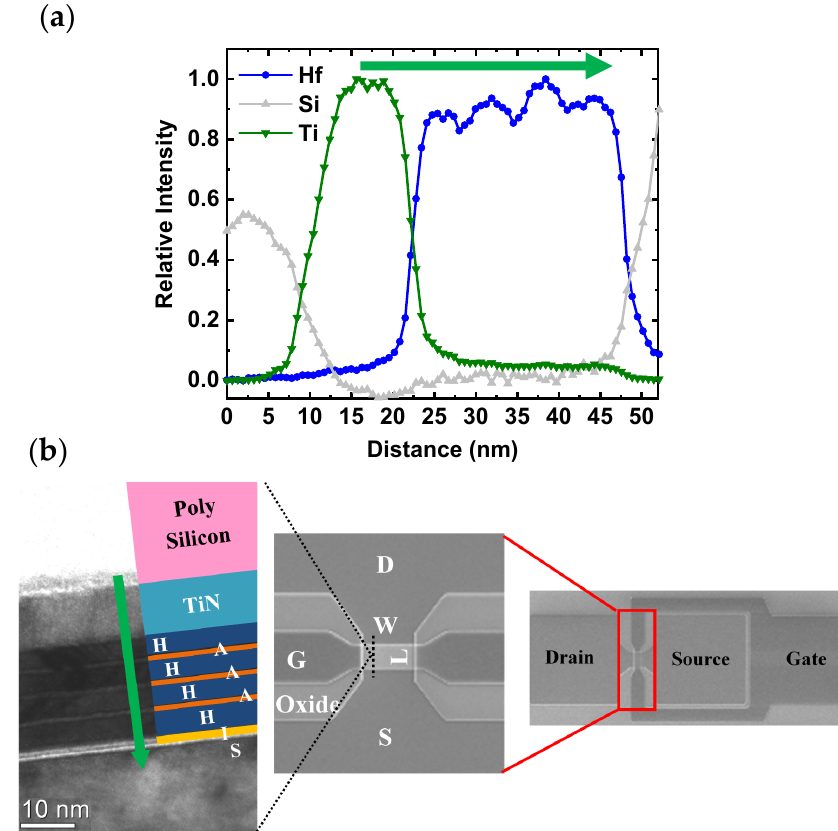
Figure 3. ( a , b ) The integrated FeFET scanning electron microscope (SEM) top view and transmission electron microscope (TEM) cross-section analysis of the stack with an inset of the high-k (H)/alumina (A) alternating layers along with the EDX line-scan of the stack elemental distribution. Repro-